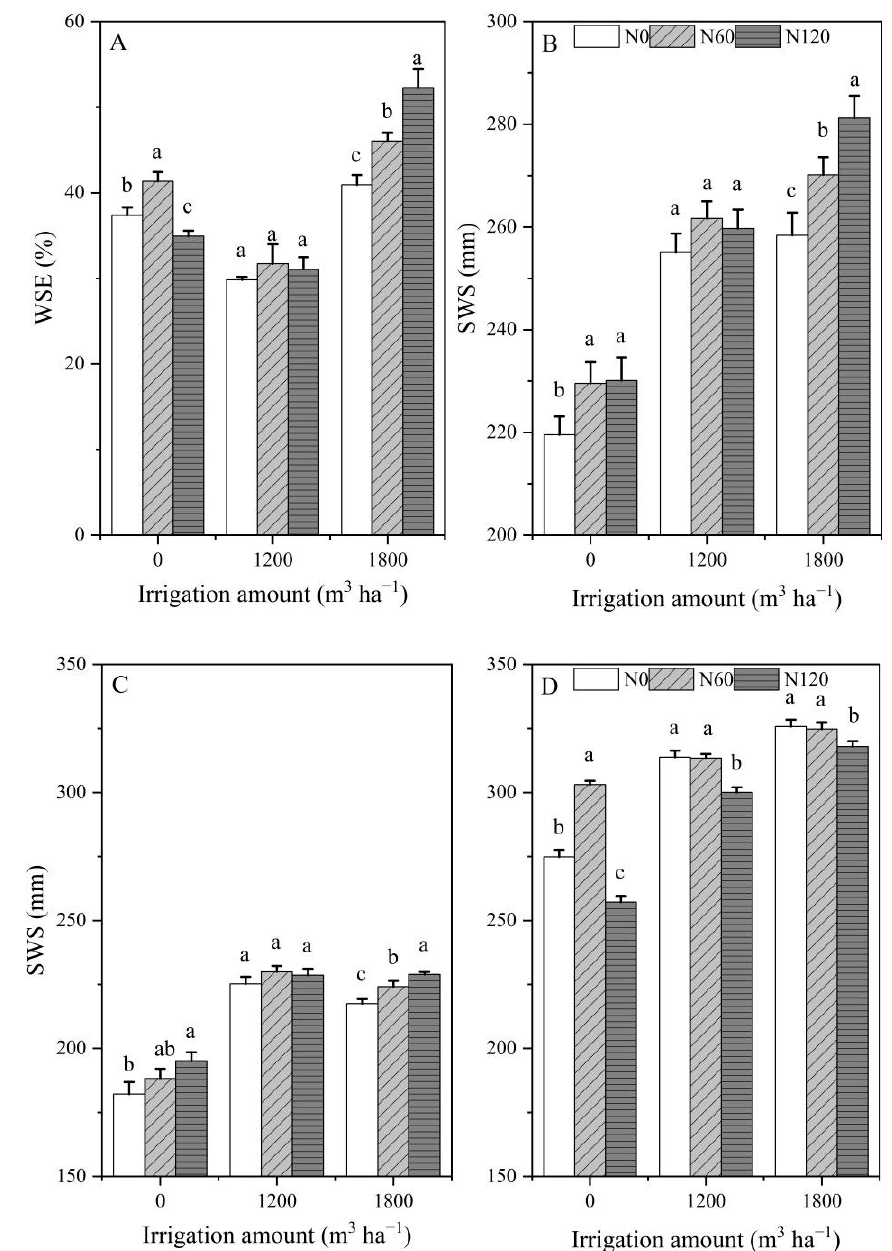
Figure 3. Response of WSE ( A ) and before sowing SWS ( B ) to irrigation amount in 2018; Response of after-harvest SWS to irrigation amount in 2017 ( C ) 2018 ( D ). Data are averaged across treatments. Error bars show the standard error of the mean. WSE is water storage efficiency (%), SWS is soil water storage (mm). Different lowercase letters represent the least significant difference (LSD) at p < 0.05.